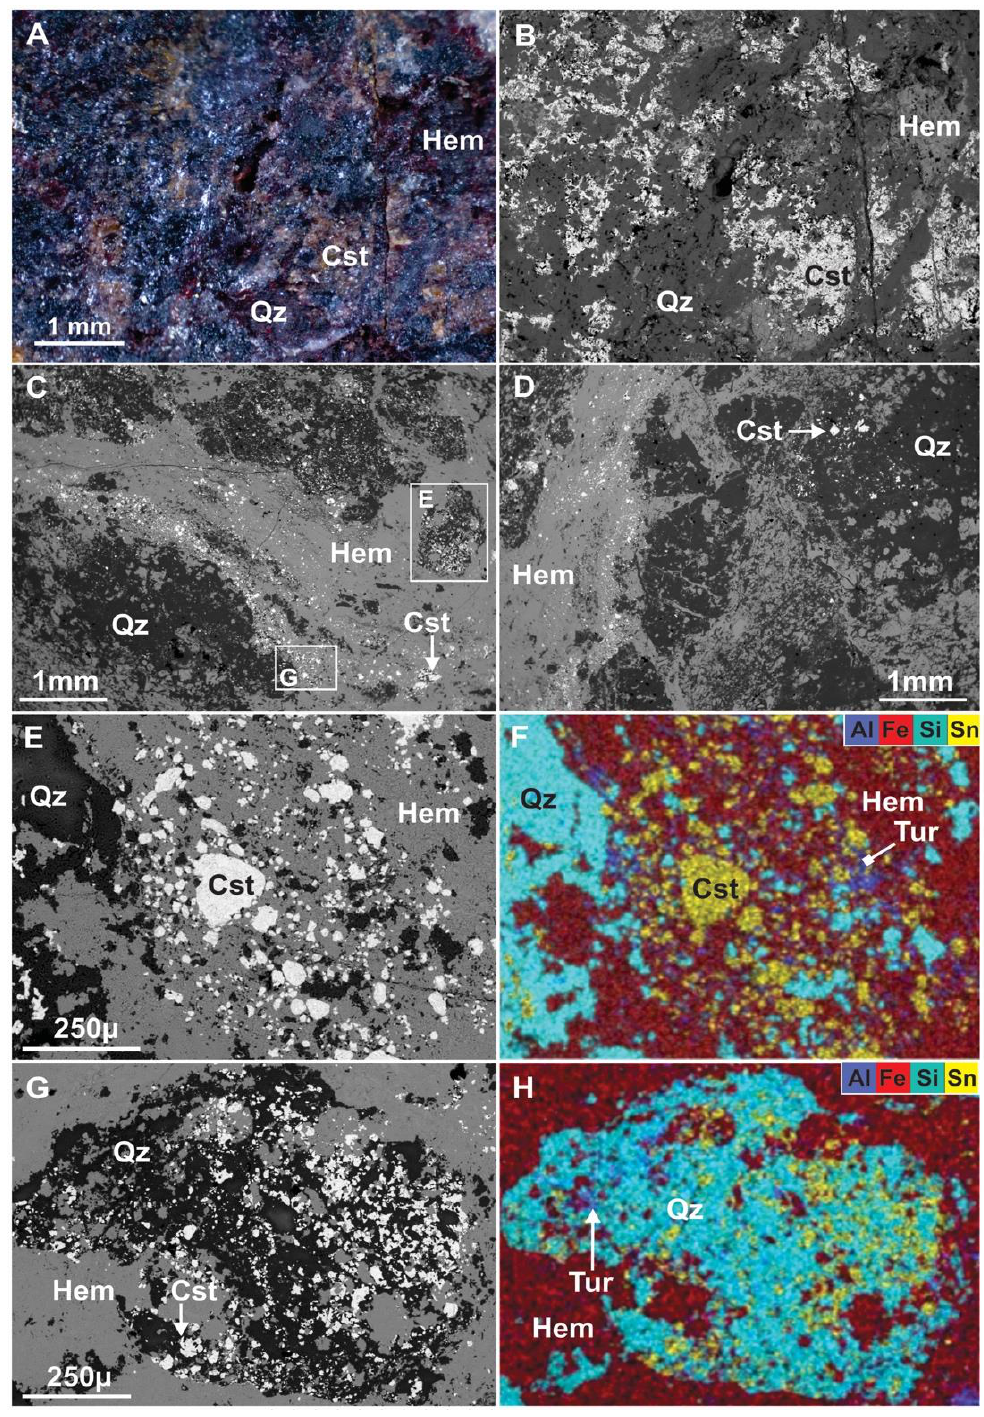
Figure 5. Hematite-Quartz-Cassiterite vein breccia. Mineral abbreviations listed in Table 1. ( A ) Photograph of ore; ( B ) Backscatter electron (BSE) image of ( A ); ( C ) Hem-Cst veinlet cutting quartz-rich breccia; ( D ) quartz clasts in Hem-Cst matrix; ( E ) close-up of Hem-Cst matrix in ( C ); ( F ) BSE image of ( E ); ( F ) close-up of Qz-Cst clast in Hem-Cst in ( C ); ( H ) X-ray map of ( G ). Hem: Hematite; Cst: Cassiterite; Qz: Quartz; Tur: Tourmaline .